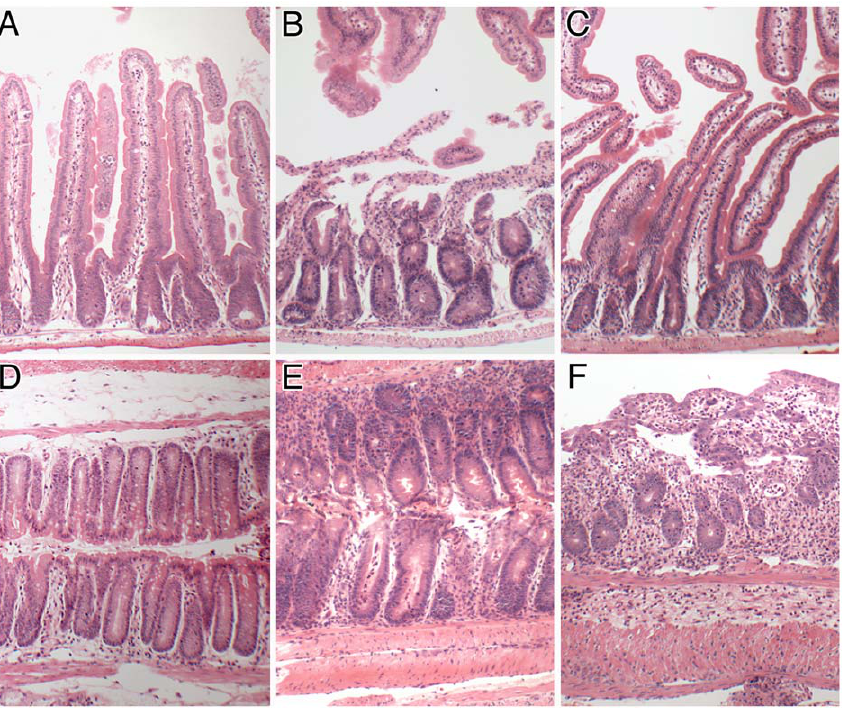
Figure 6. Histopathology of experimental mice. Small intestinal (A–C) and colonic (D–F) histology in female Rag2 KO recipients of male Rag2 KO BM 28 d previously (A, D), female Rag2 KO recipients of male SWR BM having a GvHD-like condition 28 d post BMTx (B, E) and female Rag2 KO mice in receipt of male SWR BM 28 d previously and given DSS for 5 days with 2 days recovery (C, F). Note normal histology in control mice (A, D), in contrast to small intestinal ulceration (B) and crypt abcesses (E) in GvHD-like mice, and crypt destruction and inflammation in colons (F) of DSS treated BMTx mice. Original magnifications 100X.